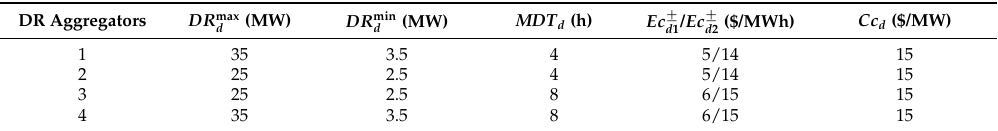
Figure 5. DR dispatch scheme of aggregators 1–4 in the first stage. Aggregator 2 is dispatched with the highest proportion, and aggregator 1 is the second highest. Table 5. DR Aggregators Characteristics.